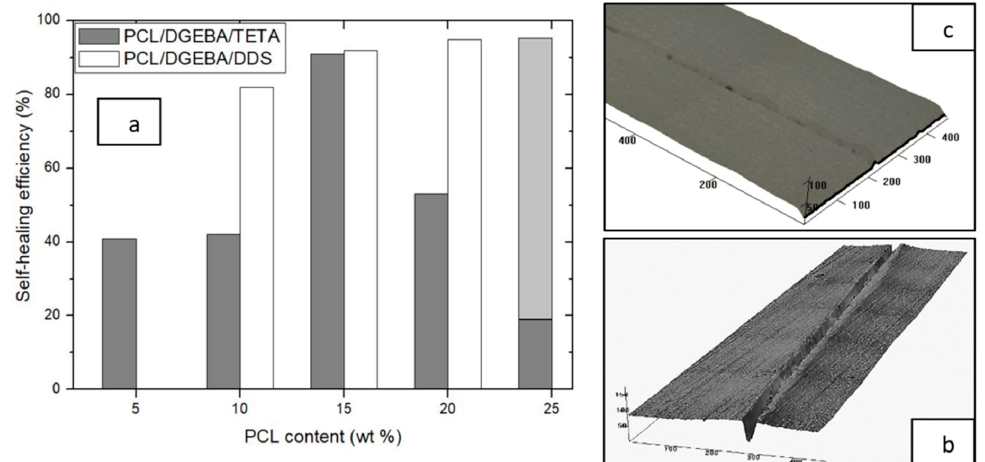
Figure7. Self-healinge ffi ciencyofPCL / epoxyblends( a ). Imagesofopticalperfilometryfornon-repaired Figure 7. Self-healing efficiency of PCL/epoxy blends ( a ). Images of optical perfilometry for non- repaired ( b ) and self-healed cracks ( c ) for DGEBA/DDS blend reinforced with 15% PCL. ( b ) and self-healed cracks ( c ) for DGEBA / DDS blend reinforced with 15% Table 1. Image analysis results of blends morphology.